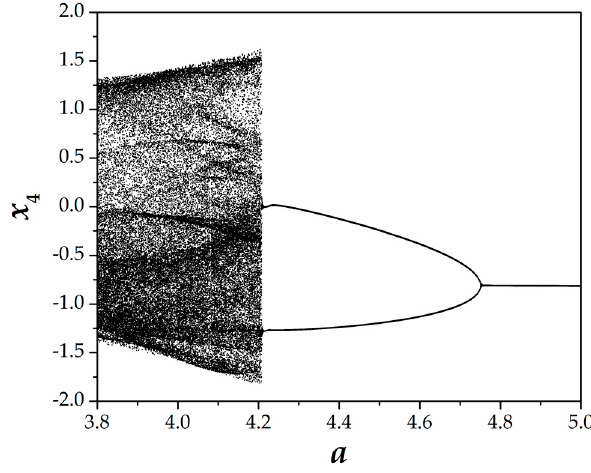
Figure 3. Bifurcation diagram of system (8)’s variable x 4 versus the parameter a , for b = 0.1 and c = 1.5.